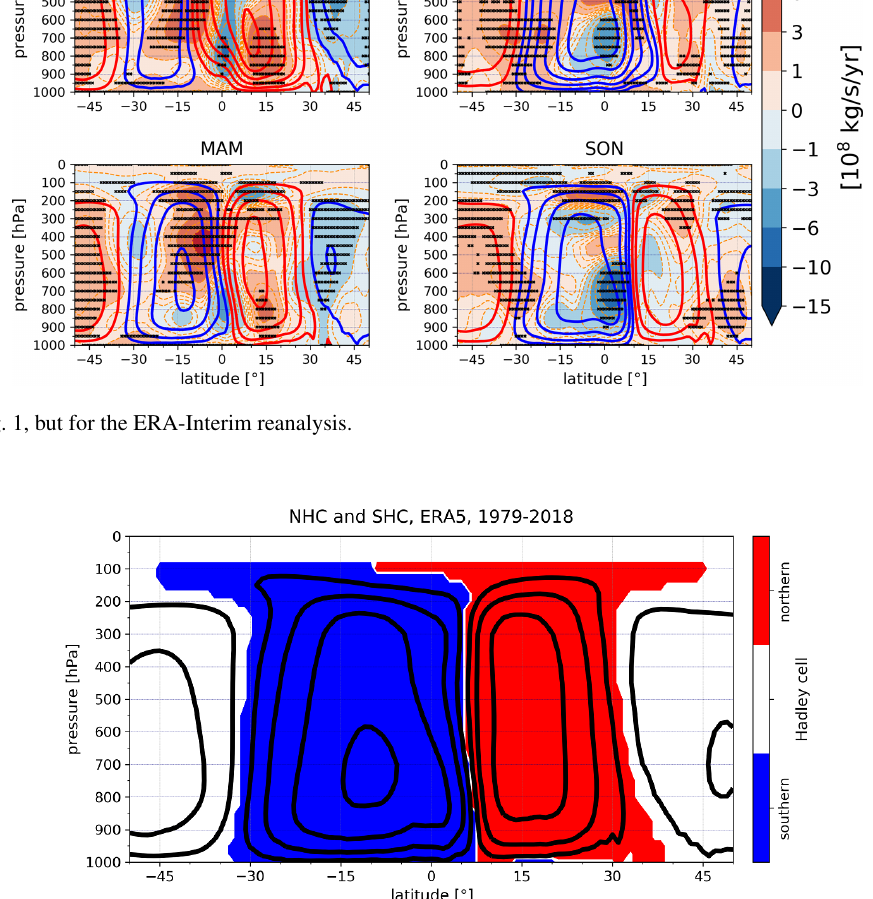
Figure A2. The area (red/blue) where the stream function is spatially averaged to evaluate NHC/SHC strength following metric (7) for the case of 1979–2018 average zonal-mean stream function in ERA5 reanalysis. The averaging area is data adaptive.